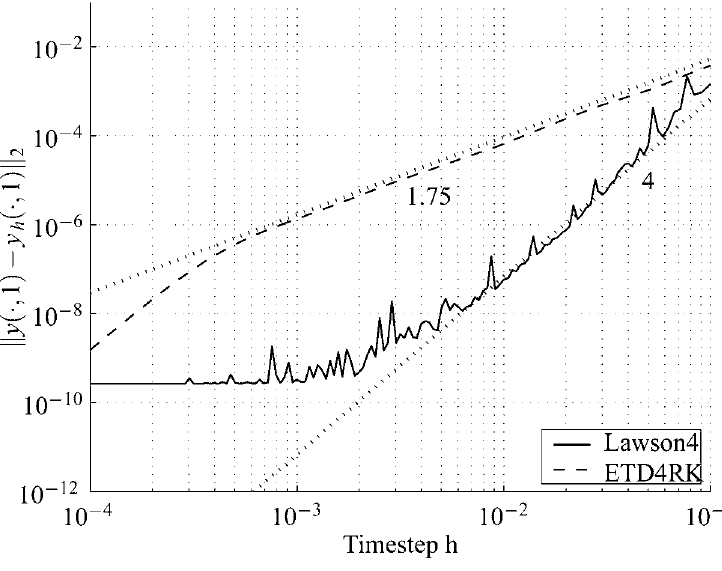
Figure 6. Smooth potential, initial condition of regularity